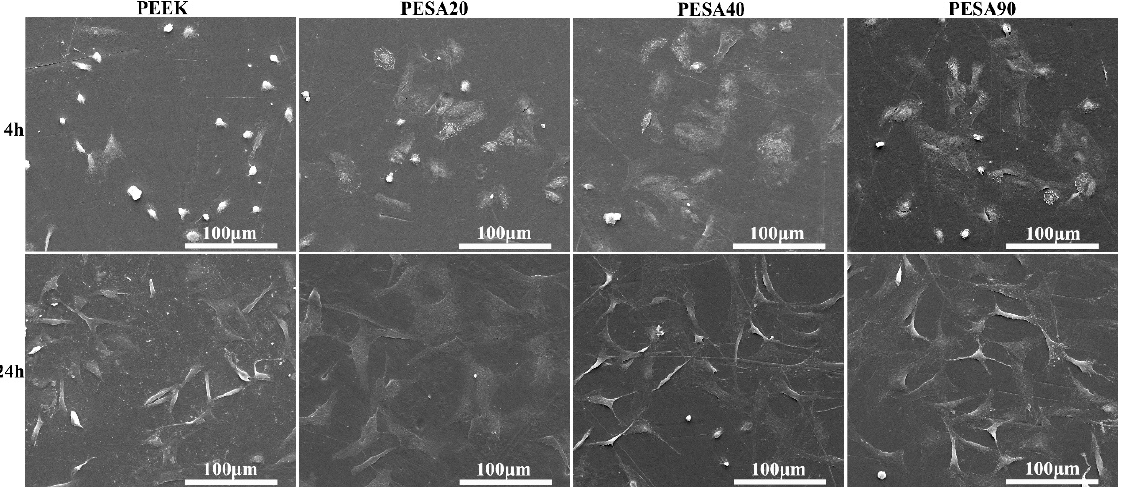
Figure 5. The morphology of MC3T3-E1 osteoblast on different samples after 4 and 24 h of culture.